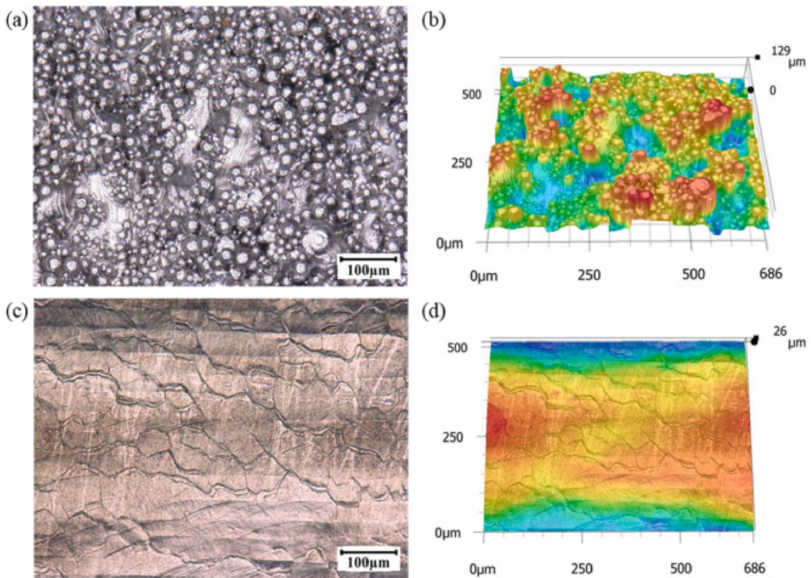
Figure 14. Surface condition before and after laser polishing. ( a ) Optical image of the manufactured surface. ( b ) 3D analysis of the surface. Color map and scale show larger surface roughness. ( c ) Optical image of the laser polishing surface. ( d ) three-dimensional analysis of the laser polishing surface. (Reprinted with permission from ref. [125]. Copyright 2021 Elsevier).